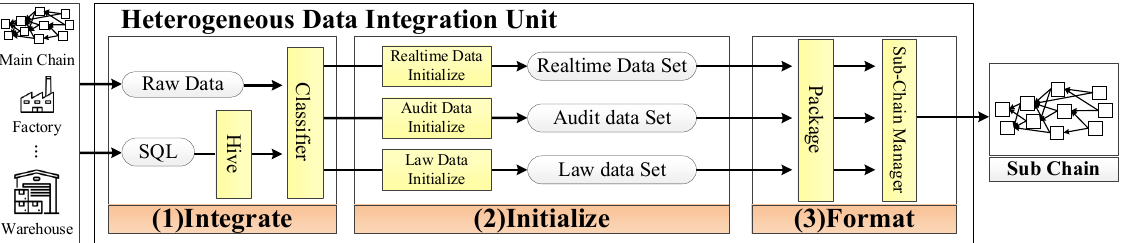
Figure 7. The flowchart of the heterogeneous data integration unit.